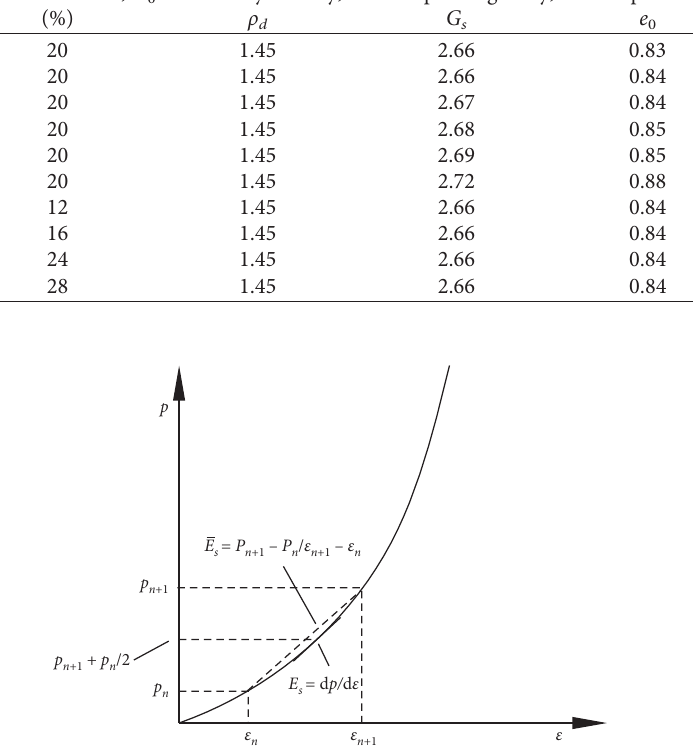
Figure 5: Sketch of secant and tangent compression